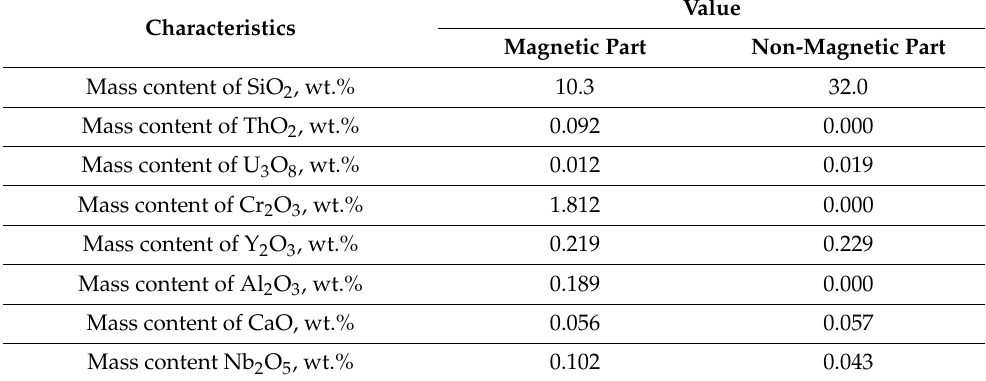
Value Magnetic Part Non-Magnetic Part